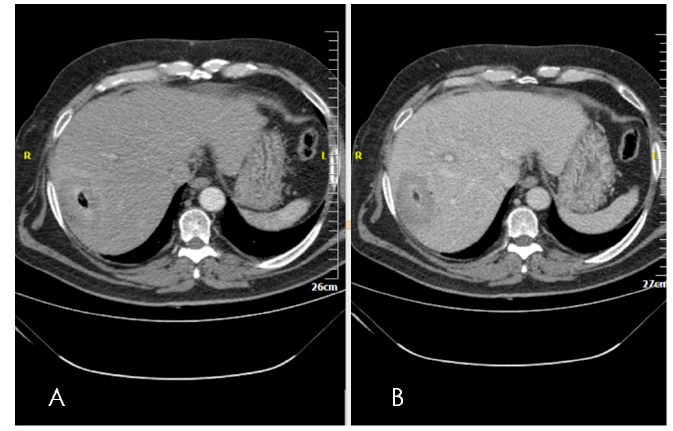
Figure 1. Computed Tomography axial scan in arterial ( A ) and portal venous phase; ( B )